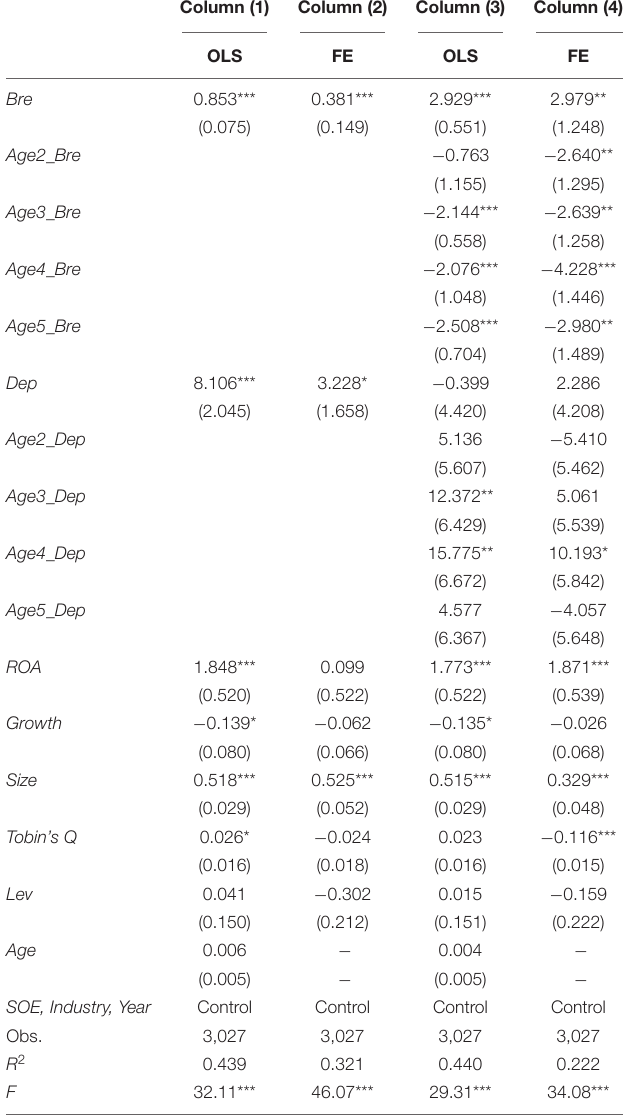
TABLE 2 | Talent inflow network, life cycle, and firms’ innovation.